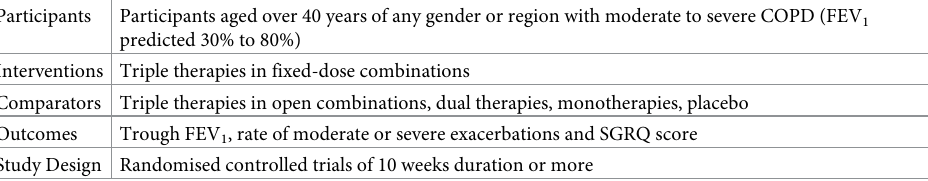
Table 2. Summary of eligibility